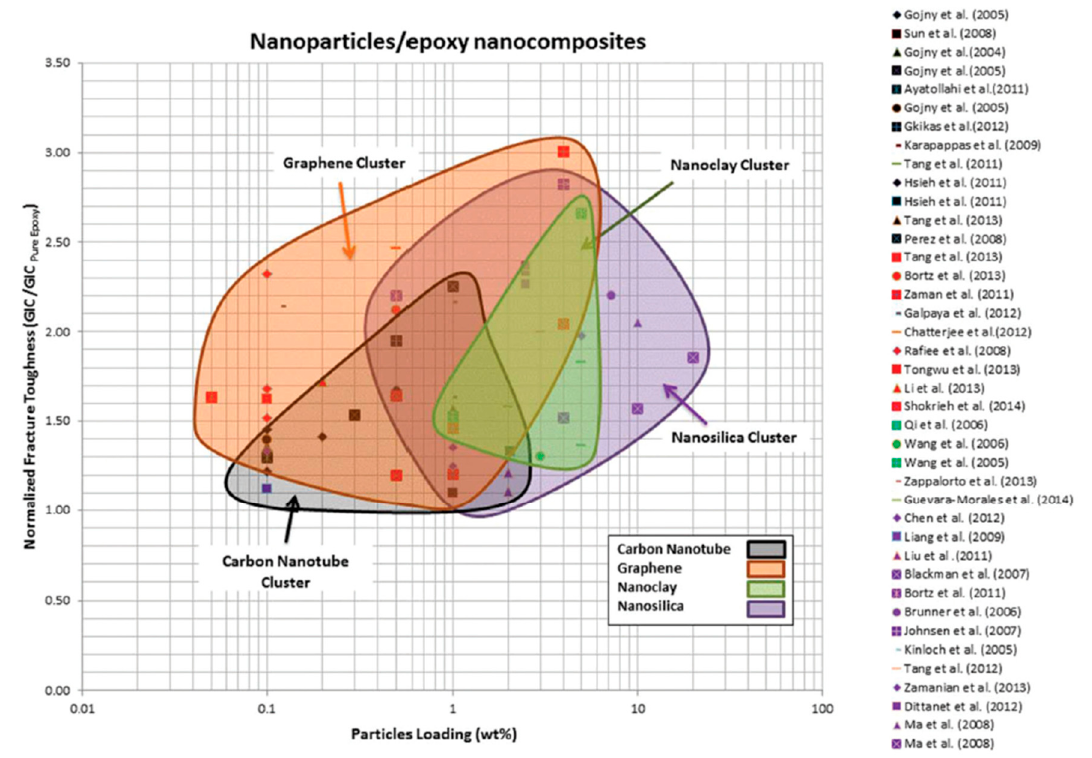
Figure 1. Map of fracture toughness of nanoparticles / epoxy nanocomposites with respect to particle loading [2].